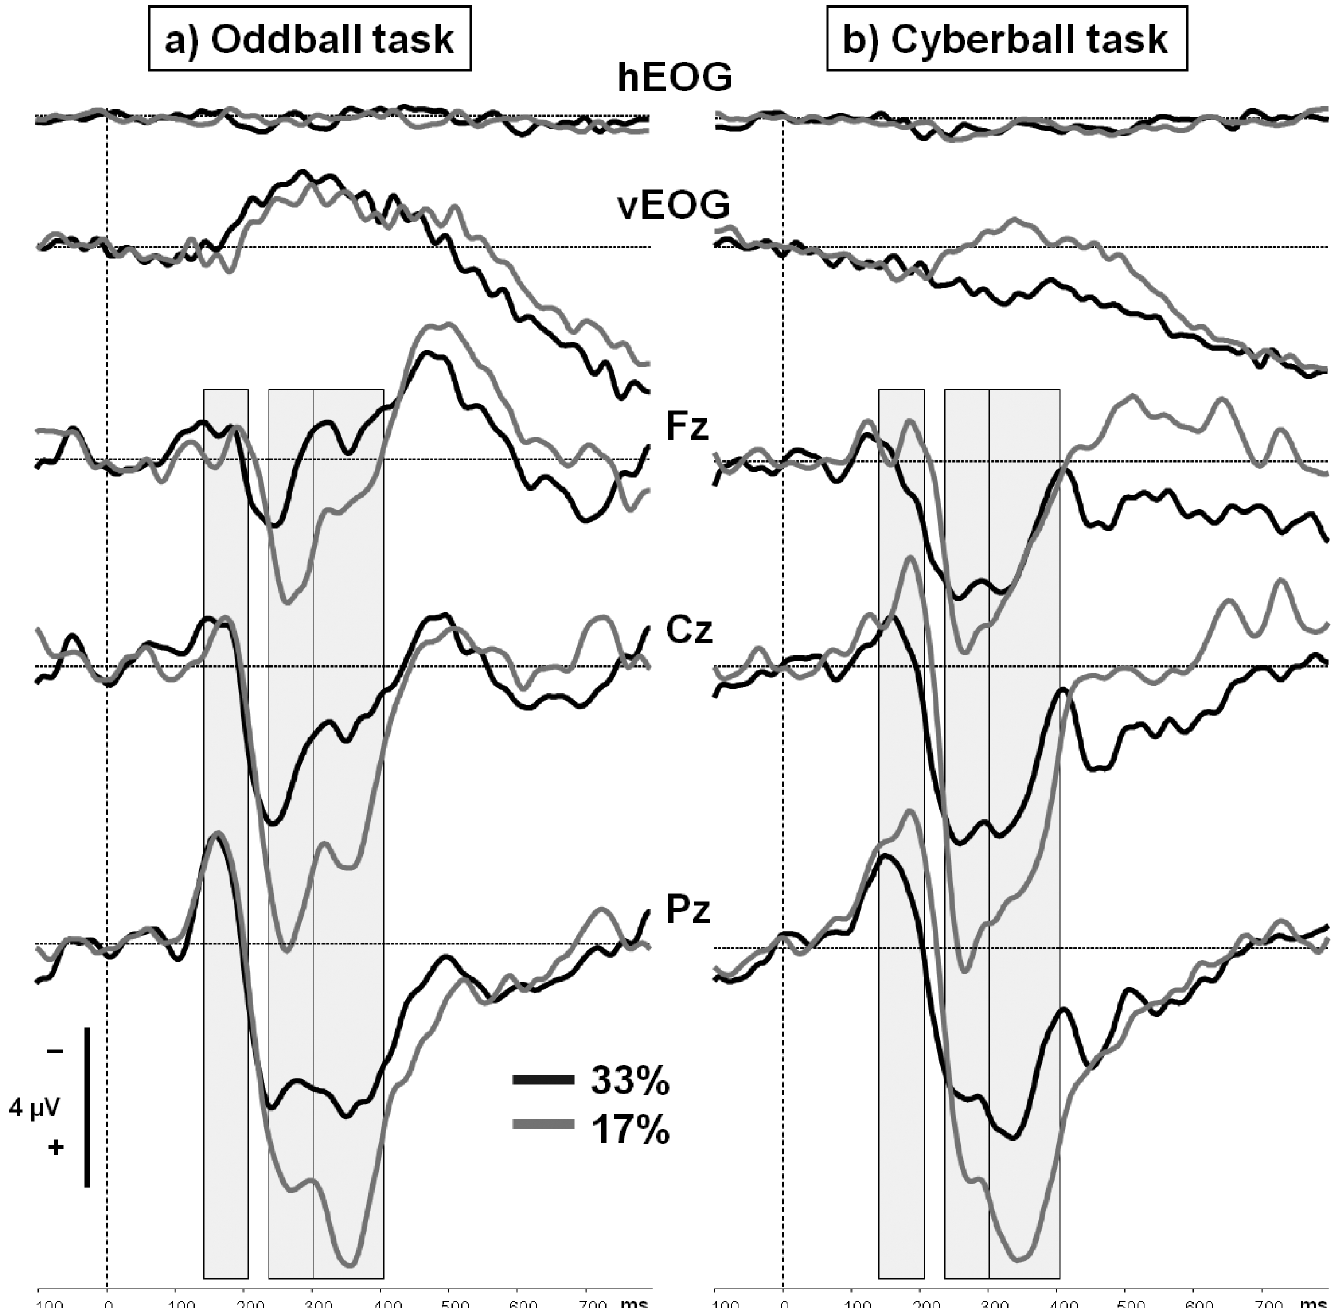
Fig 2. Grand-averaged ERPs for target events. Grand-averaged ERPs and horizontal and vertical EOGs for the target events (a: Oddball task, circle at position “ C ” ; b: Cyberball task, ball possession of the participant) in the first (33% target probability; black lines) and the second (17% target probability; grey lines) block of the tasks. ERPs were recorded from the electrode positions Fz, Cz, and Pz. A parietal N2 (130 – 210 ms) was followed by a P3 complex with a centrally located P3a (240 – 300 ms) and a P3b (300 – 410 ms) with a parietal maximum. The target event was presented at 0